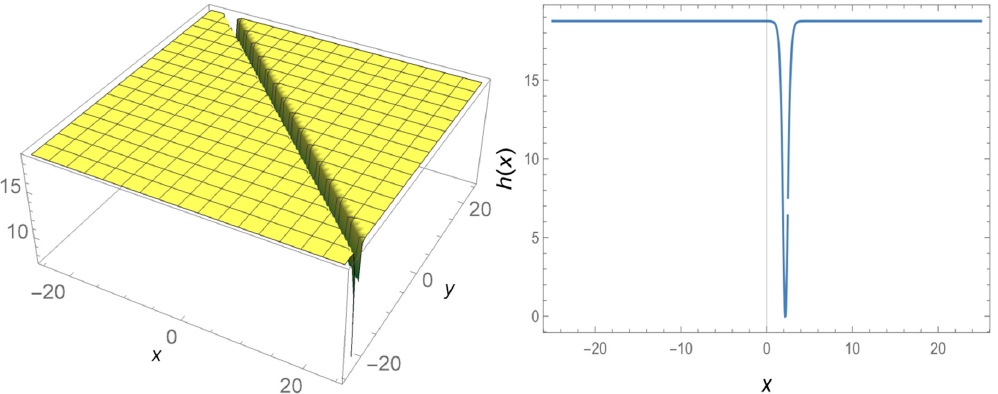
Figure 1. Three-dimensional and 2D graphs of Equation (15) for t = 2, θ 0 = 1, λ = 0.3, m = 2, µ = 0.5, d = 2, ρ = 2, τ = 1, b = 1, (cid:36) = 1 values and y = 2 for 2D.